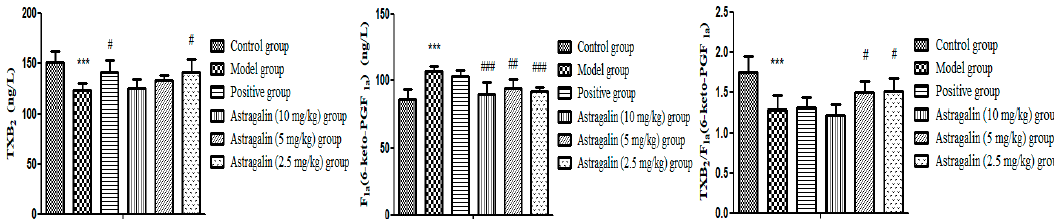
Figure 6. E ff ects of astragalin on TXB 2 and 6-Keto-PGF 1 α (X ± SD, n = 8) . Compared with the control Figure 6. Effects of astragalin on TXB 2 and 6-Keto-PGF 1 α ( X ± SD, n = 8) . Compared with the